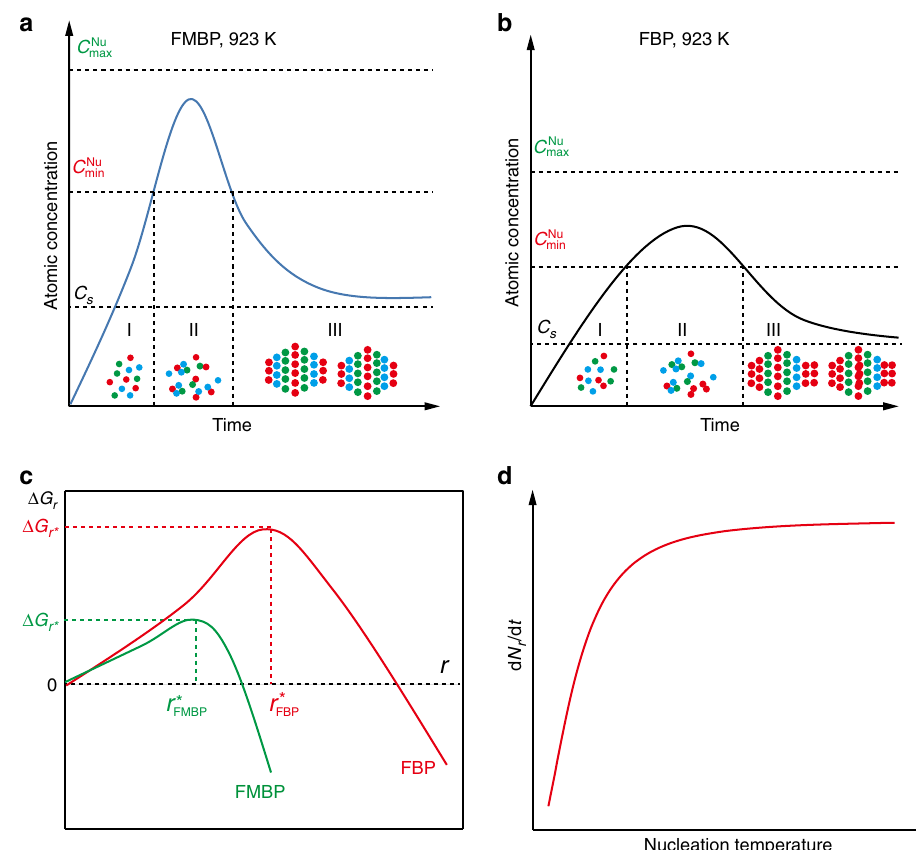
Fig. 5 Mechanism of formation of nanocrystals by FMBP and FBP. a The diagrams of formation of monomers (I), nucleation (II), and growth of nanocrystal (III) versus the reaction time by FMBP. b The diagrams of formation of monomers (I), nucleation (II), and growth of nanocrystal (III) phases versus the reaction time by FBP. c The corresponding overall free energy change (( Δ G r ) versus the nucleus size ( r ) via FMBP, and FBP strategies. d The effect of nucleation temperature on the nucleation rate (d N r /d t